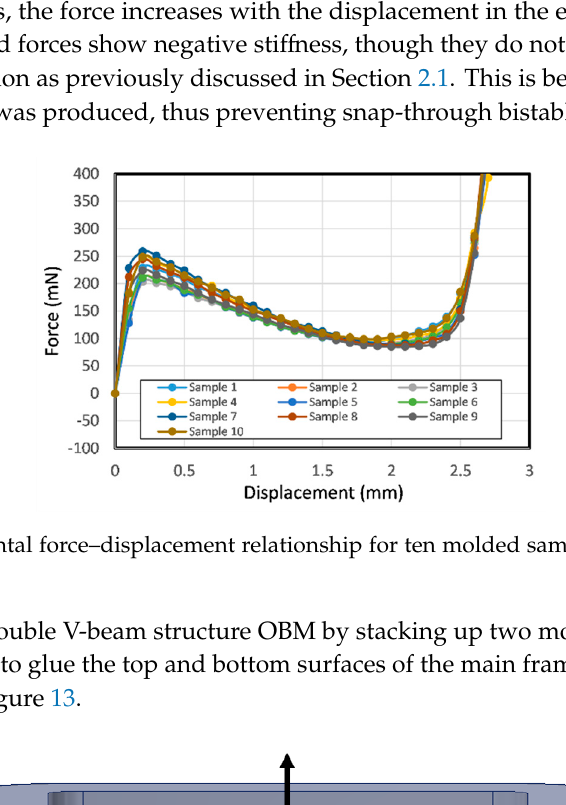
Figure 11. Setup of the force-displacement measurement experiment.